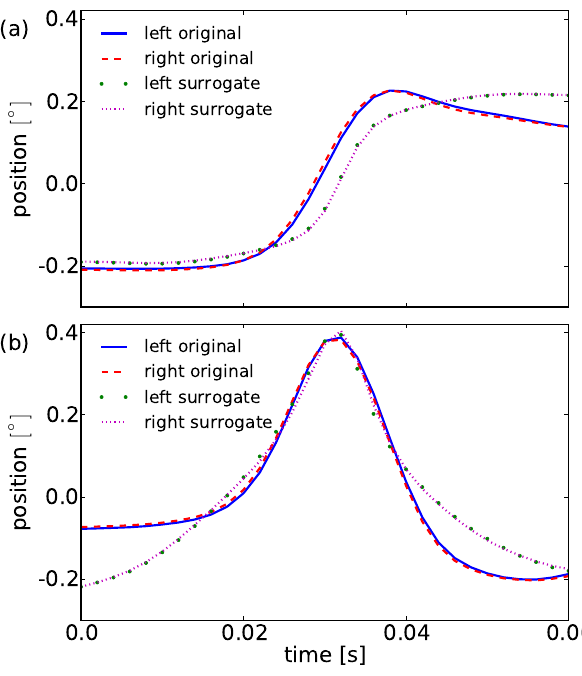
Figure 9 . Representation of the first principal components’ shapes for the original data and surrogate data. Compare (a) pc 0 and pc 0 s , the typical overshoot behavior in the smooth step is not present. Left (blue solid line) and right (red dashed line) eye again show approximately the same principal com- ponent in original as well as in surrogate data (green dotted and magenta dash-dotted line). (b) The second component for the original pc 1 is a bump whether pc 1 s is a smooth peak